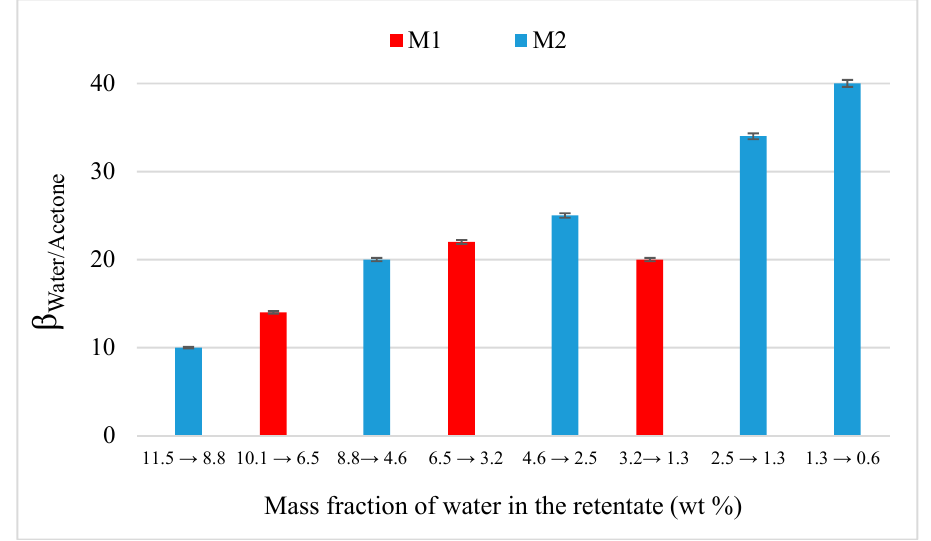
Figure 6. Evolution of separation factor water/acetone as the function of the inlet water composition through M1 and M2 at 30 °C.